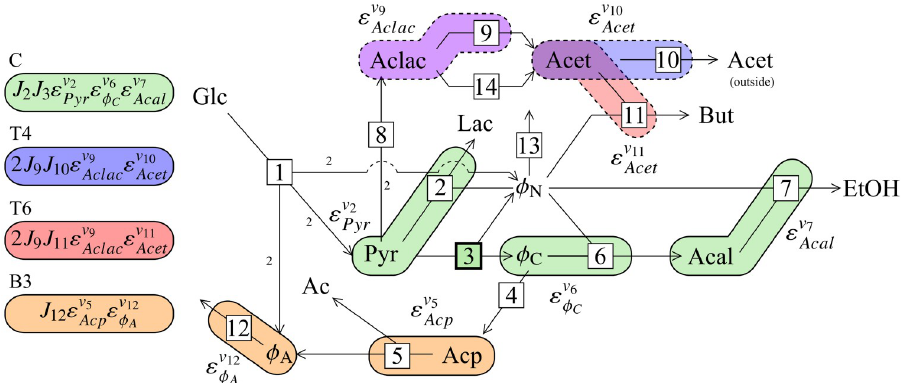
Fig 5. The components of control patterns 063 and 071 of C J 6 . Backbone and multiplier patterns that constitute the v 3 dominant control patterns of group 3 and group 4 (CP063 and CP071) are indicated as groups of coloured bubbles that highlight their elasticity coefficient components as indicated by the key. These control patterns both share backbone C and multiplier B3 and are therefore differentiated based on their incorporation of either multiplier T4 (CP063) or T6 (CP071).